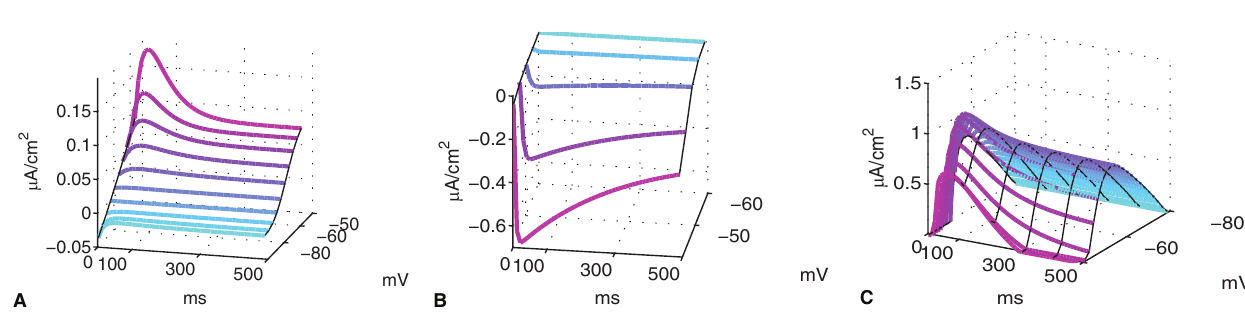
Figure 3. Activation-inactivation (temporal) dynamics. ( A ) dynamics for the slow A channel I As ( B ) the L-type Ca channel I CaL , and (C) for the set of ion channels used in the standard MSN model. We see a rise-time due to I As and overlapping inactivation dynamics in the -55 to -40 mV range.